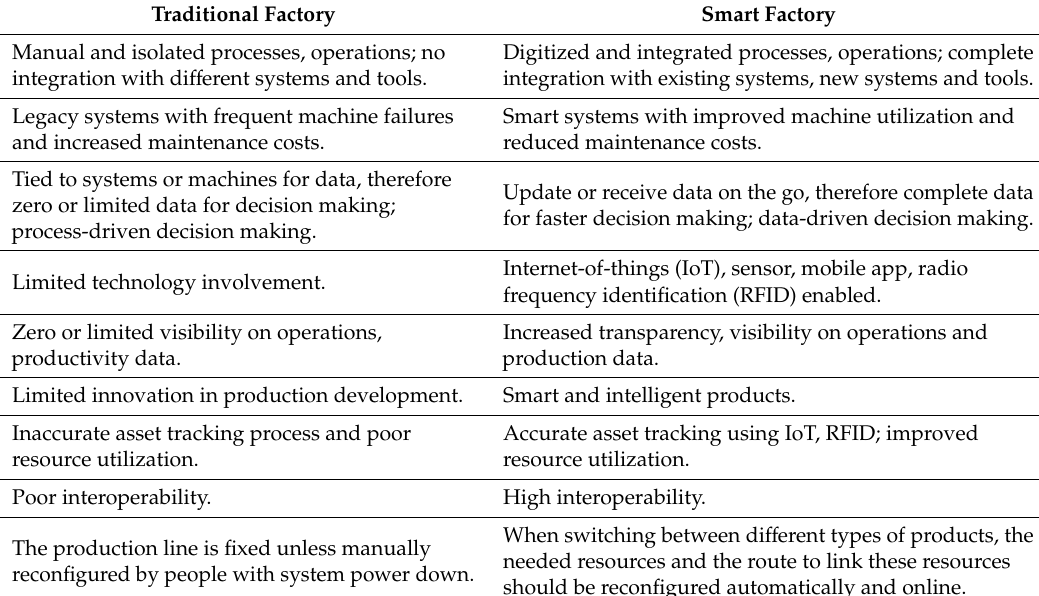
Table 1. Key di ff erences between the traditional manufacturing factory and smart factory. Traditional Factory Smart